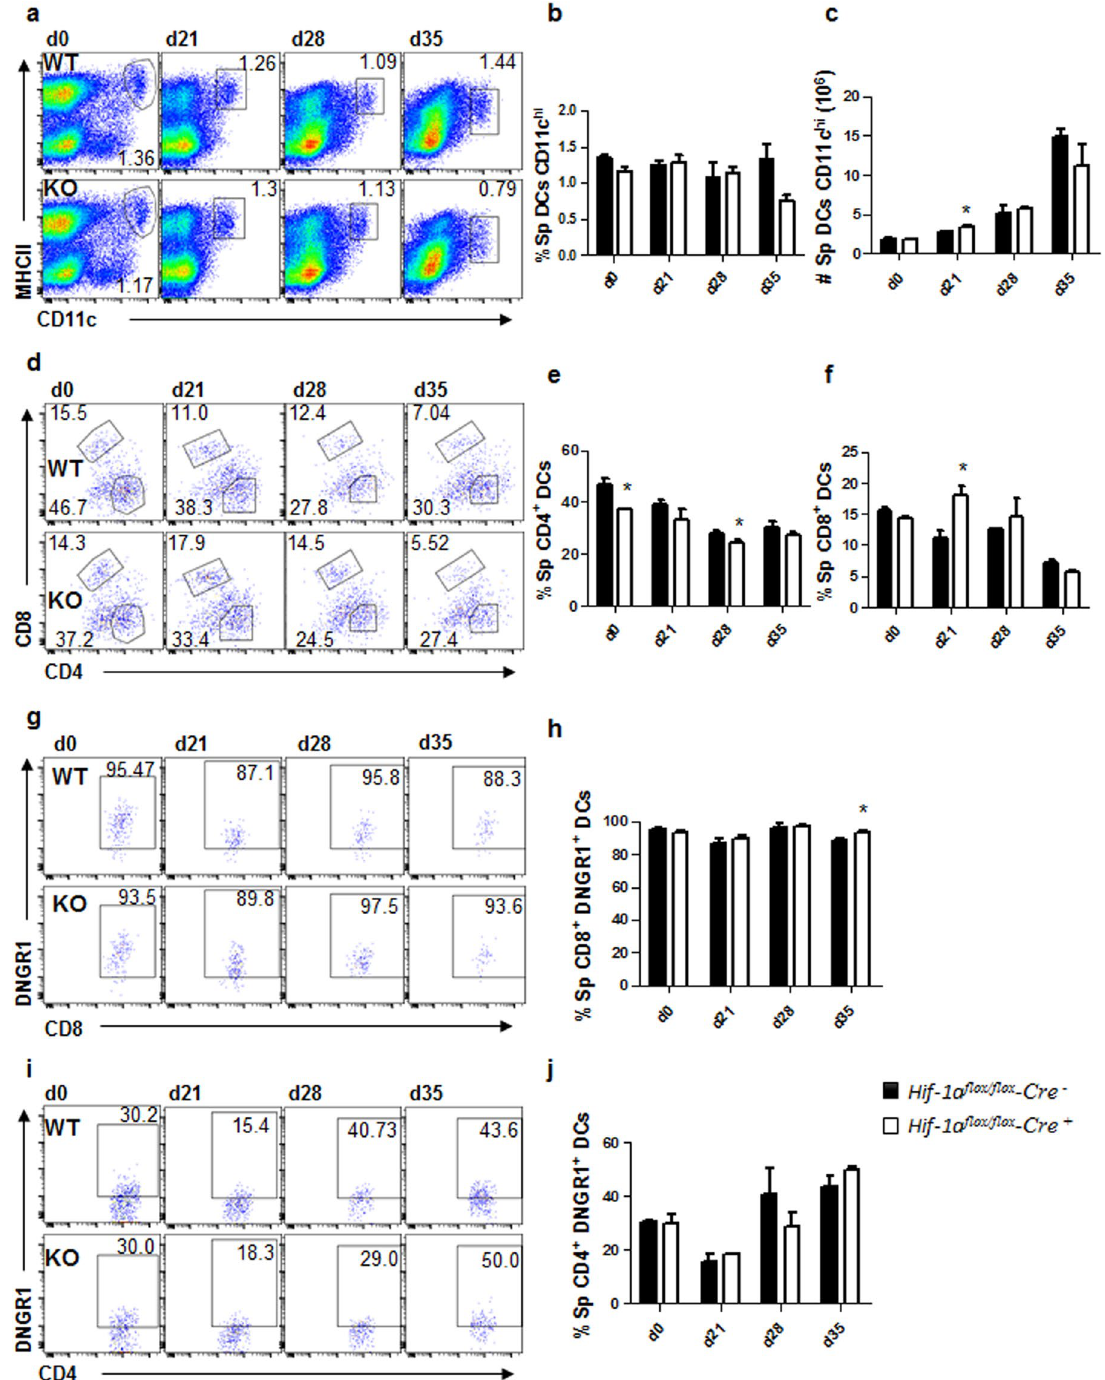
Figure 4. Dendritic cell migration to the spleen is not affected by the absence of HIF-1 α . Hif-1 α flox/flox Cd11c- Cre − (WT) and Hif-1 α flox/flox Cd11c-Cre + (KO) mice were infected with 2 × 10 7 LV9 amastigotes intravenously. ( a ) Representative plots showing splenic CD11c hi DCs of Cre − (upper panels) and Cre + (lower panels) mice over the course of infection. Graphs represent the frequency ( b ) and absolute numbers ( c ) of CD11c hi MHCII hi cells in the spleen. ( e,f ) Frequency of splenic CD11c hi MHCII hi CD4 + ( d ) and CD11c hi MHCII hi CD8 + ( e ) cells. ( g,h ) Representative plots ( g ) and percentages ( h ) of DNGR-1 + CD8 + dendritic cells. ( h,i ) Representative plots ( i ) and percentages ( j ) of DNGR-1 + CD4 + dendritic cells. All data represent mean ± SEM of one of 3 independent experiments, n =